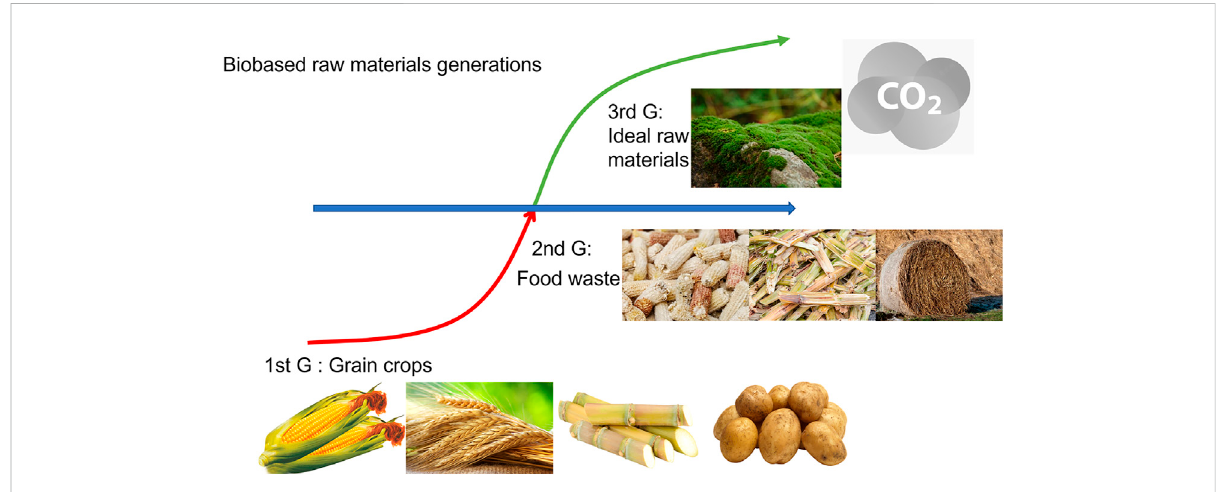
FIGURE 5 Generations of Biobased raw materials for textile fi